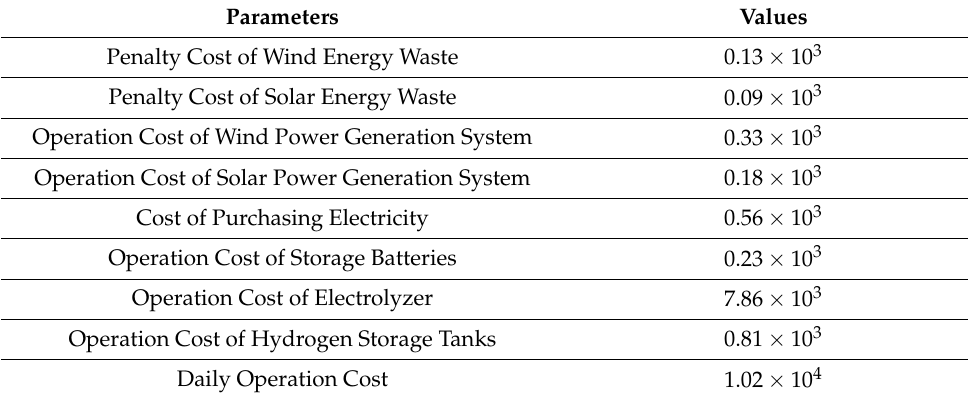
Table 4. Operation Cost of Each Part in the